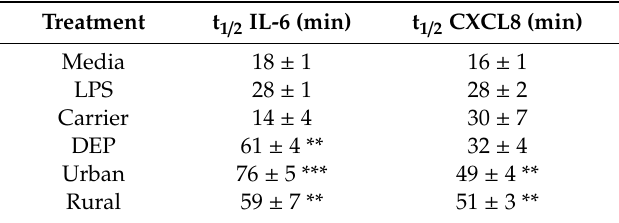
mRNA half-lives were calculated from time-course experiments by linear regression. Values are expressed as the mean ± SEM ( n = 3). ** p ≤ 0.01, *** p ≤ 0.001 compared to